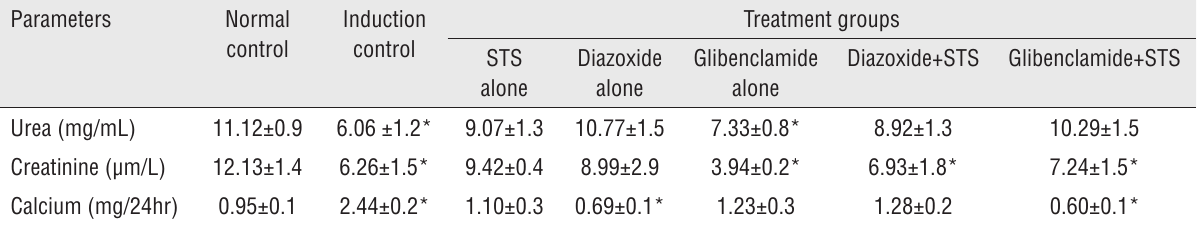
Table 1 - urine Chemistry. Parameters